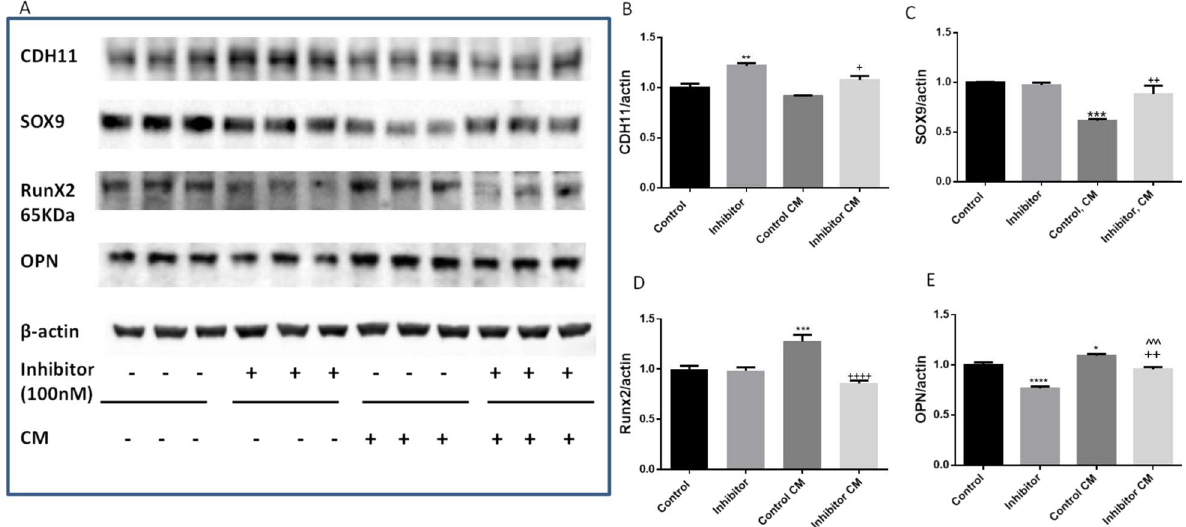
Fig. 6 Inhibition of miR-101 rescued downregulation of CDH-11 and SOX9 expression and prevented osteogenesis in CM-treated HAVICs. A Western blot against antibodies of CDH11, SOX9, Runx2, and OPN in HAVICs transfected with miR-101-3p inhibitor for 48 h and then treated with CM for additional 48 h. β-actin serves as internal loading control. B – E Quantification of CDH11, Sox9, Runx2 and OPN protein expression normalized with β-actin. Data means SEM. **P < 0.01 and ***P < 0.001 vs Control; + P < 0.05, ++ P < 0.001 and ++++ P < 0.0001 vs Control, CM. n = ±